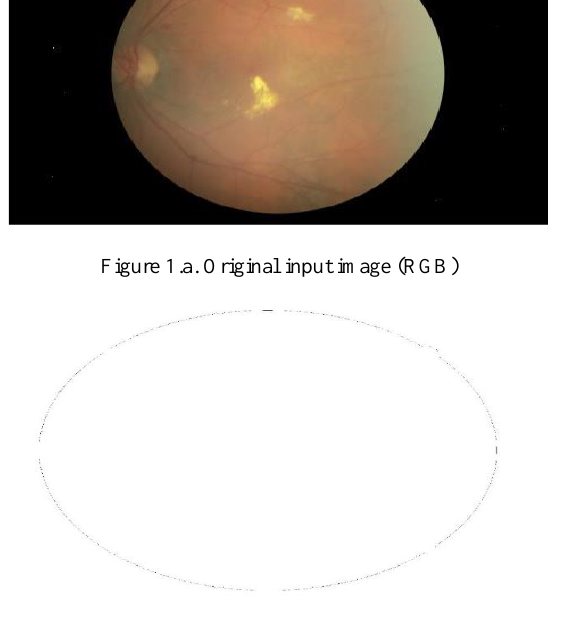
Figure 1.b. Borderline of ROI